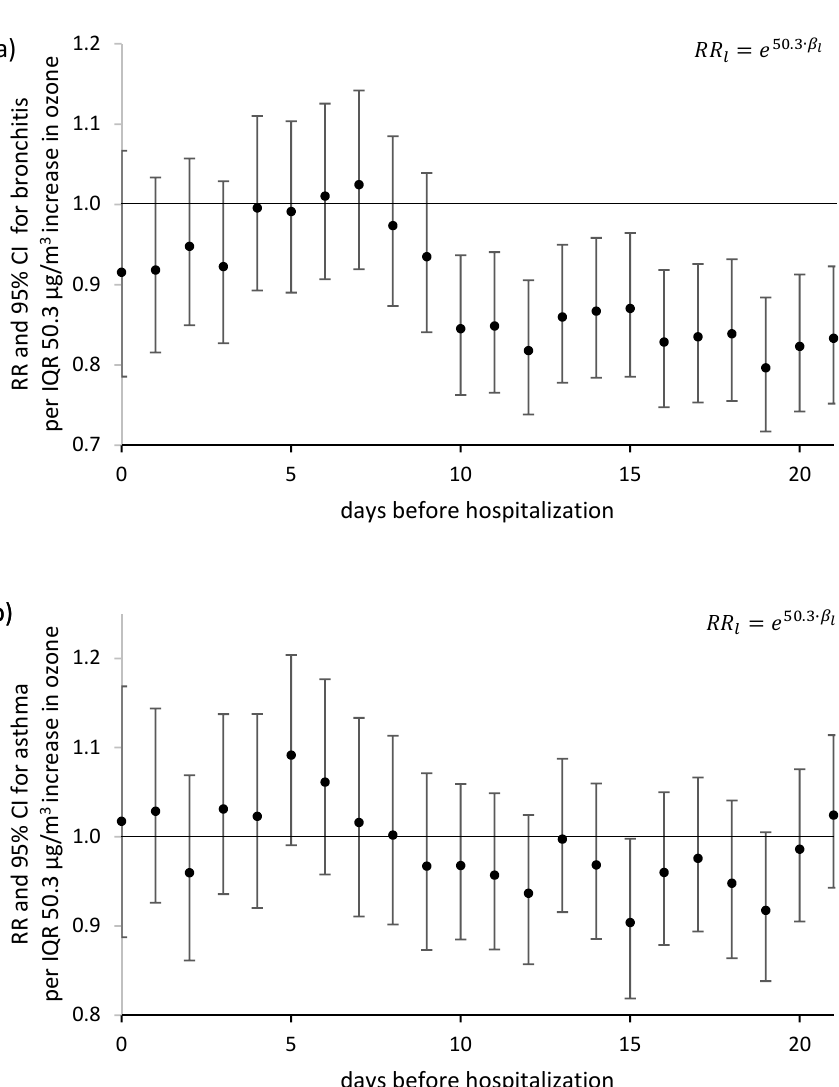
Figure 3. Relative risk RR l of daily hospitalizations due to: ( a ) bronchitis (J20–J21), ( b ) asthma (J45–J46), related to 8 h ozone concentration increase by the interquartile range—IQR 50.3 µ g / m 3 . The day 0—the day of registered hospitalization; the day l —the day before hospitalization.